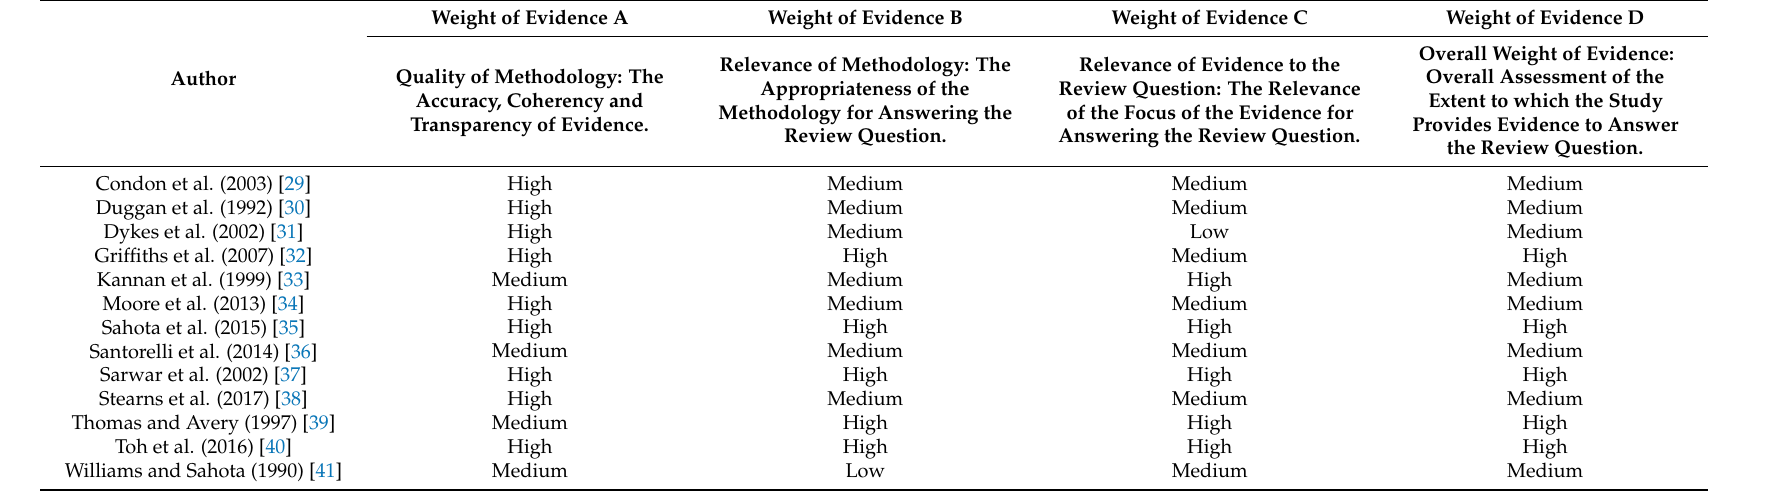
Table 1. Weight of evidence awarded to each